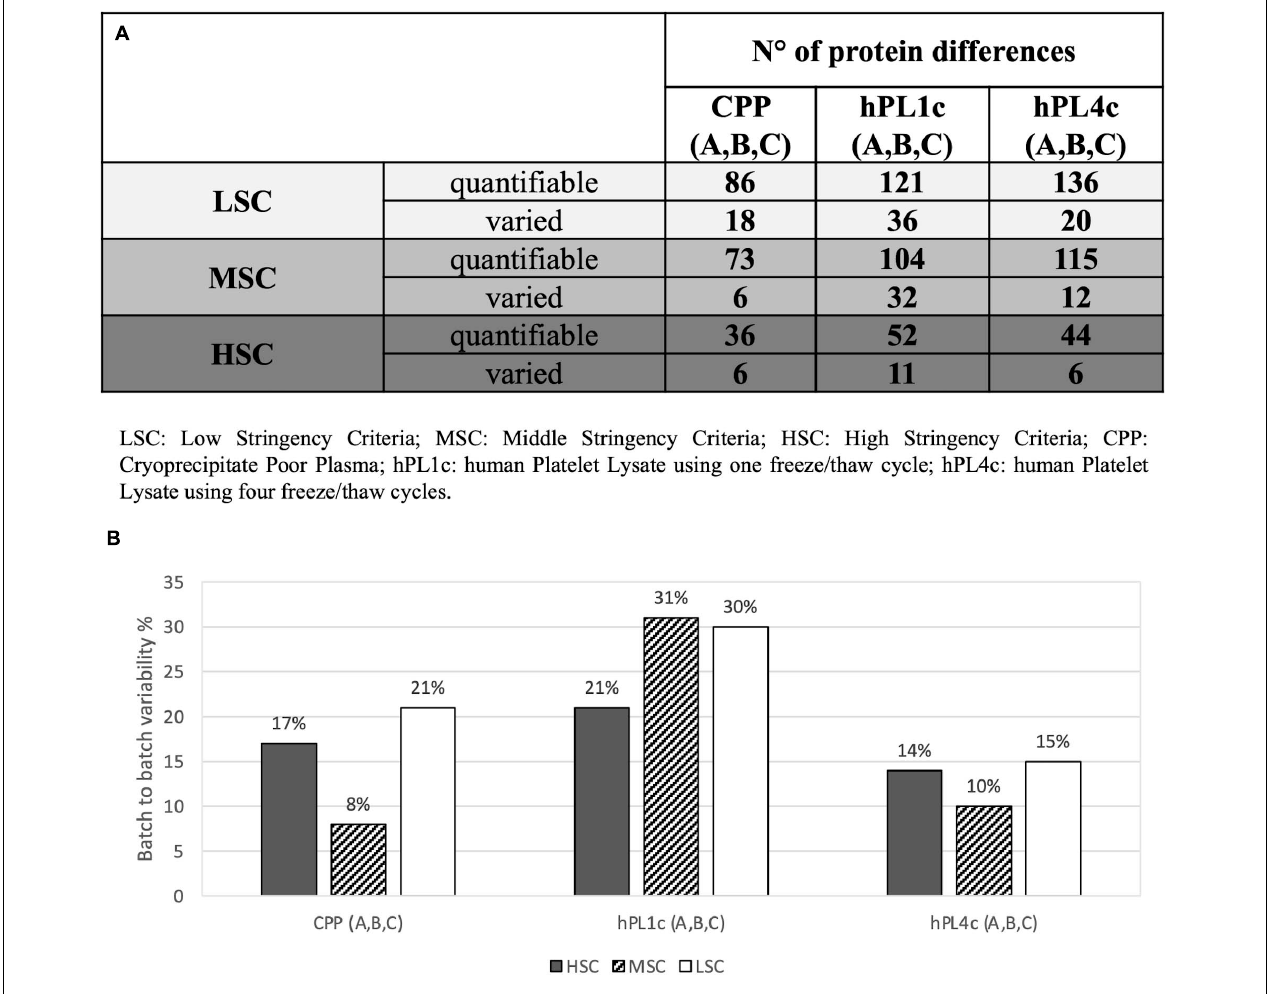
FIGURE 2 | Proteomic batch-to-batch variability in hPL1c and hPL4c and in CPP. Table and graphics report the extent of proteomic variability between different batches (A–C) for the three preparations (hPL1c, hPL4c, CPP). PEAKS Studio X+ platform was applied on outcomes from label-free relative quantification based on nLC-ESI-MS/MS. The variability was considered taking into account three different levels of stringency (LSC, low stringency criteria; MSC, middle stringency criteria; HSC, high stringency criteria) in order to make the results more reliable and to exclude any possible effect derived from data filtering. For each condition, the variability was calculated as the ratio between the proteins significantly varied between three different batches (A–C) ( p < 0.05, fold change ≥ 1.5, at least two unique peptides/protein) over the numbers of quantifiable proteins (significance = 0, at least two unique peptides/protein); (A) table with the number of quantifiable proteins and batch-to-batch significant differences for all the samples and the stringency levels; (B) graphic illustrating batch-to-batch variability in percentage (significantly varied over quantifiable proteins) for all the samples and the stringency levels. CPP, cryoprecipitate-poor plasma; hPL1c, human platelet lysate using one freeze/thaw cycle; hPL4c, human platelet lysate using four freeze/thaw